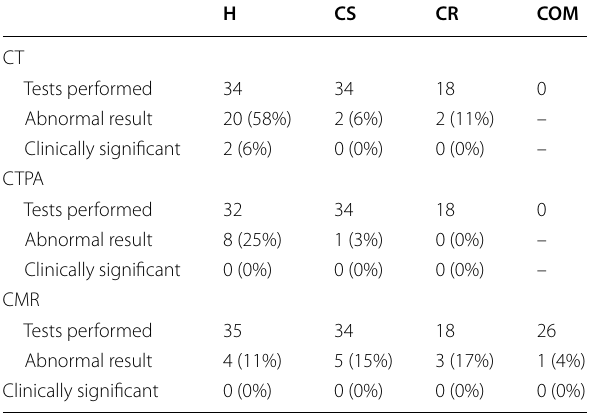
Table 5 Prevalence of participants with abnormal and clinically significant findings following clinical investigations.